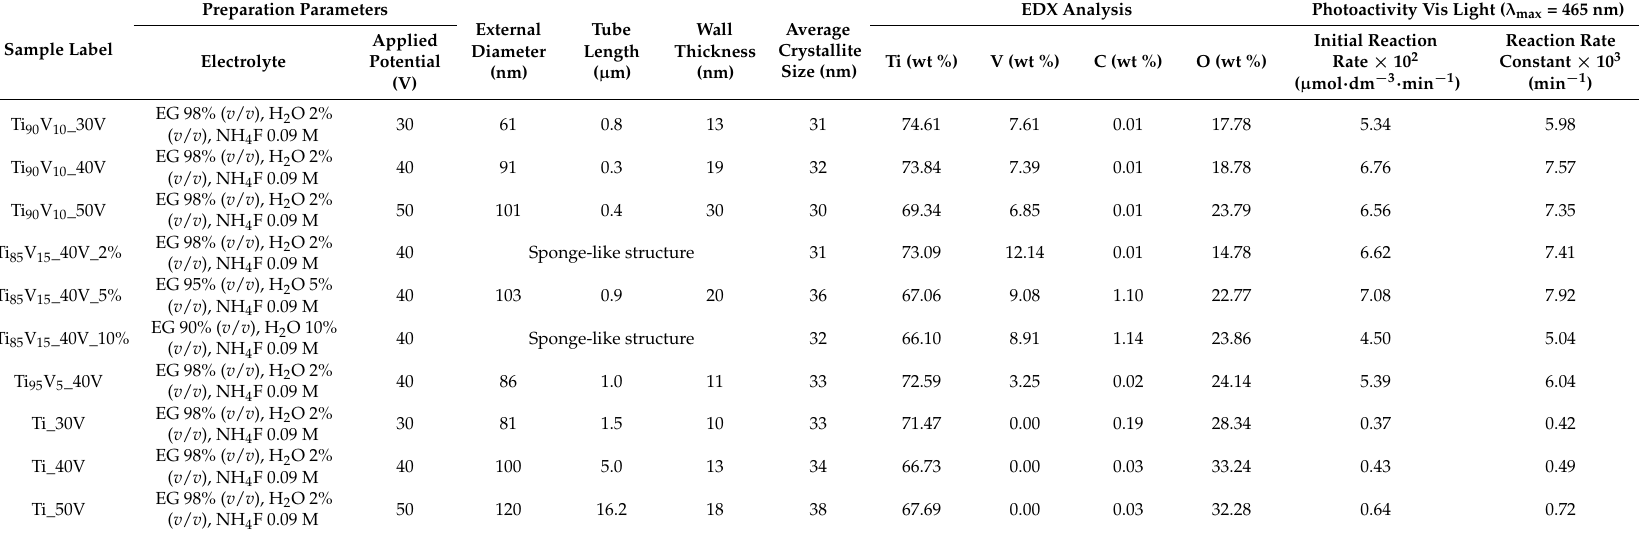
Table 1. Sample labels, preparation parameters, characterization, and photocatalytic activity of V 2 O 5 -TiO 2 nanotubes under Vis